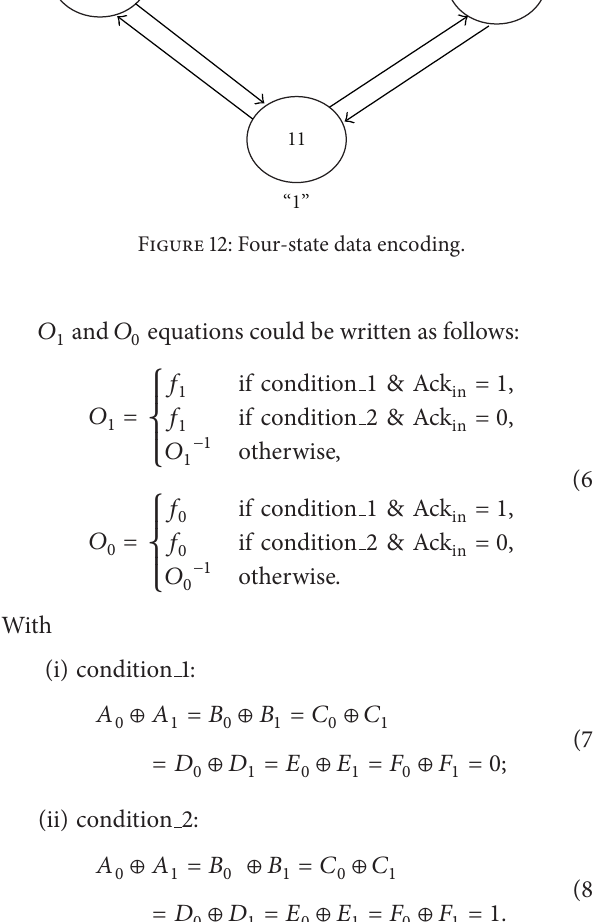
Figure 14: Current profiles of Figure 8 DES submodule block implemented on the secure